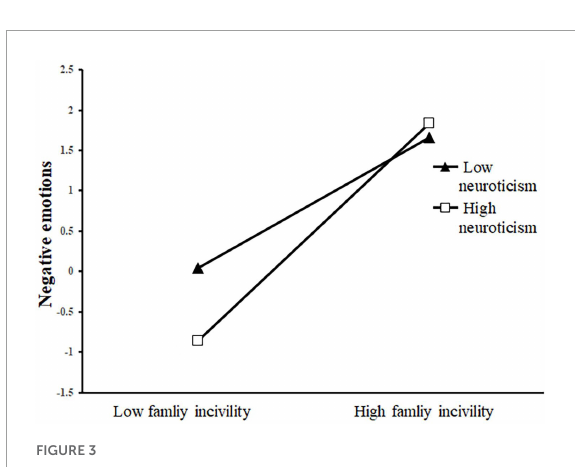
FIGURE3 Interaction effect of family incivility and neuroticism on Negative emotions. The black triangle represents low neuroticism and the white square represents high